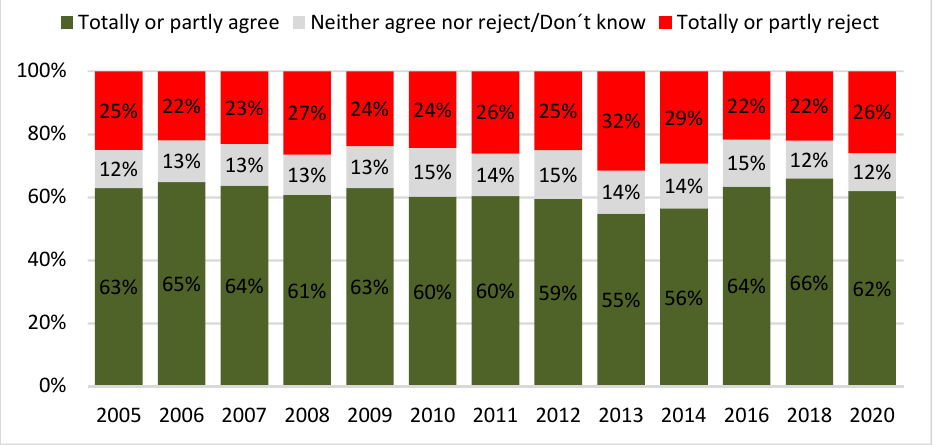
Figure 10. Negative statement about deportation if convicted: All people with foreign background who commit crime should be deported from Sweden.